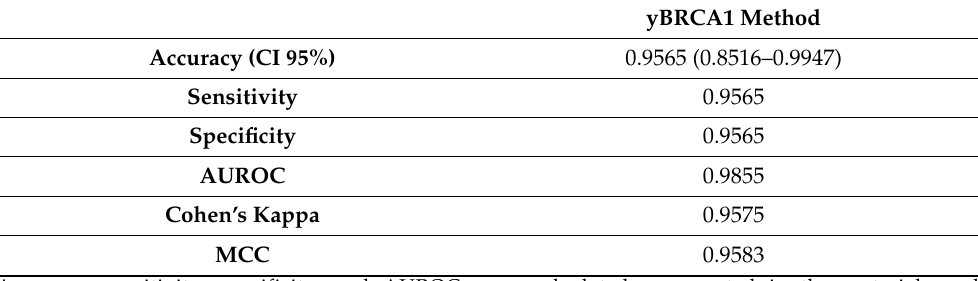
Table 2. Performance evaluation of the combination method